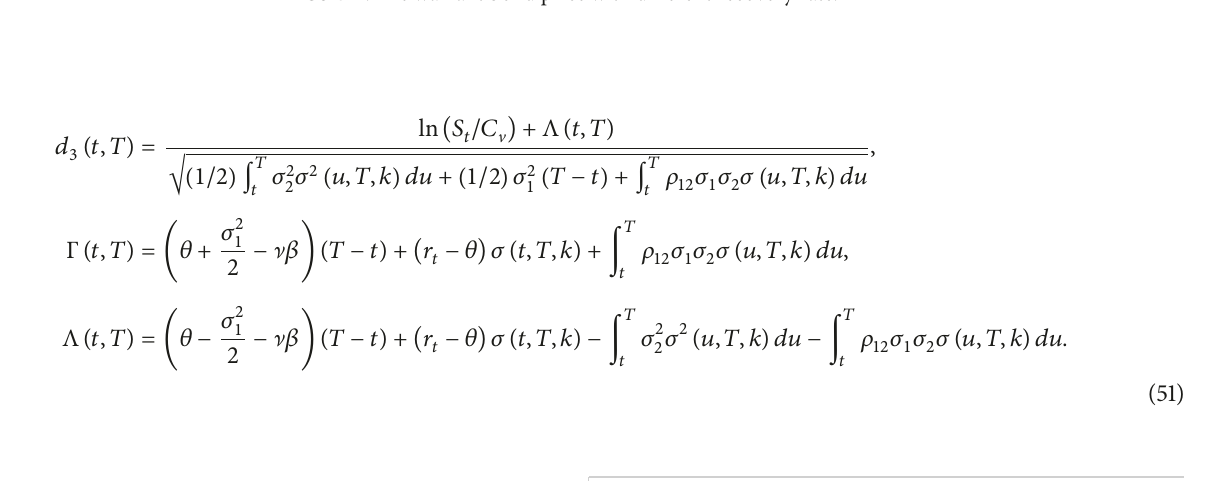
Figure 1: The warrant bond price with different recovery